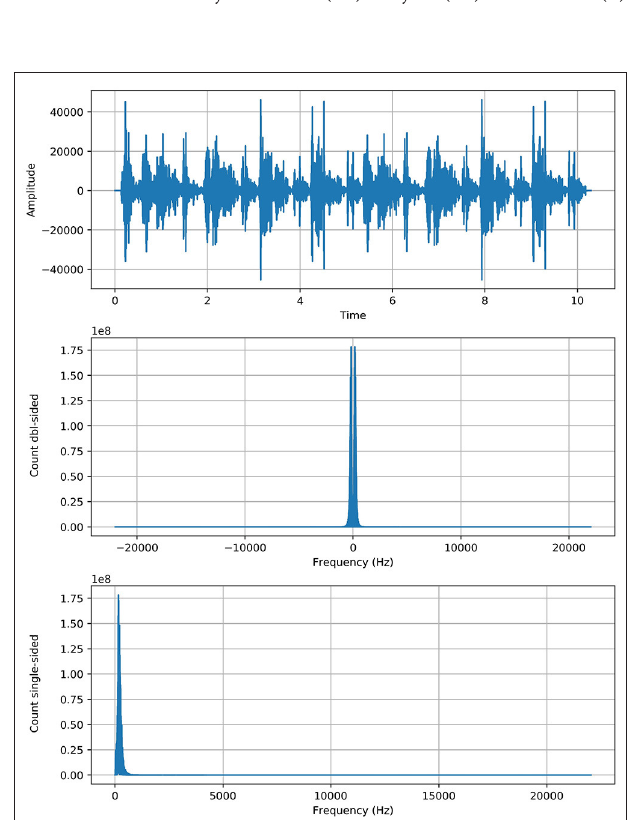
FIGURE 1 | Reboot spectrogram of